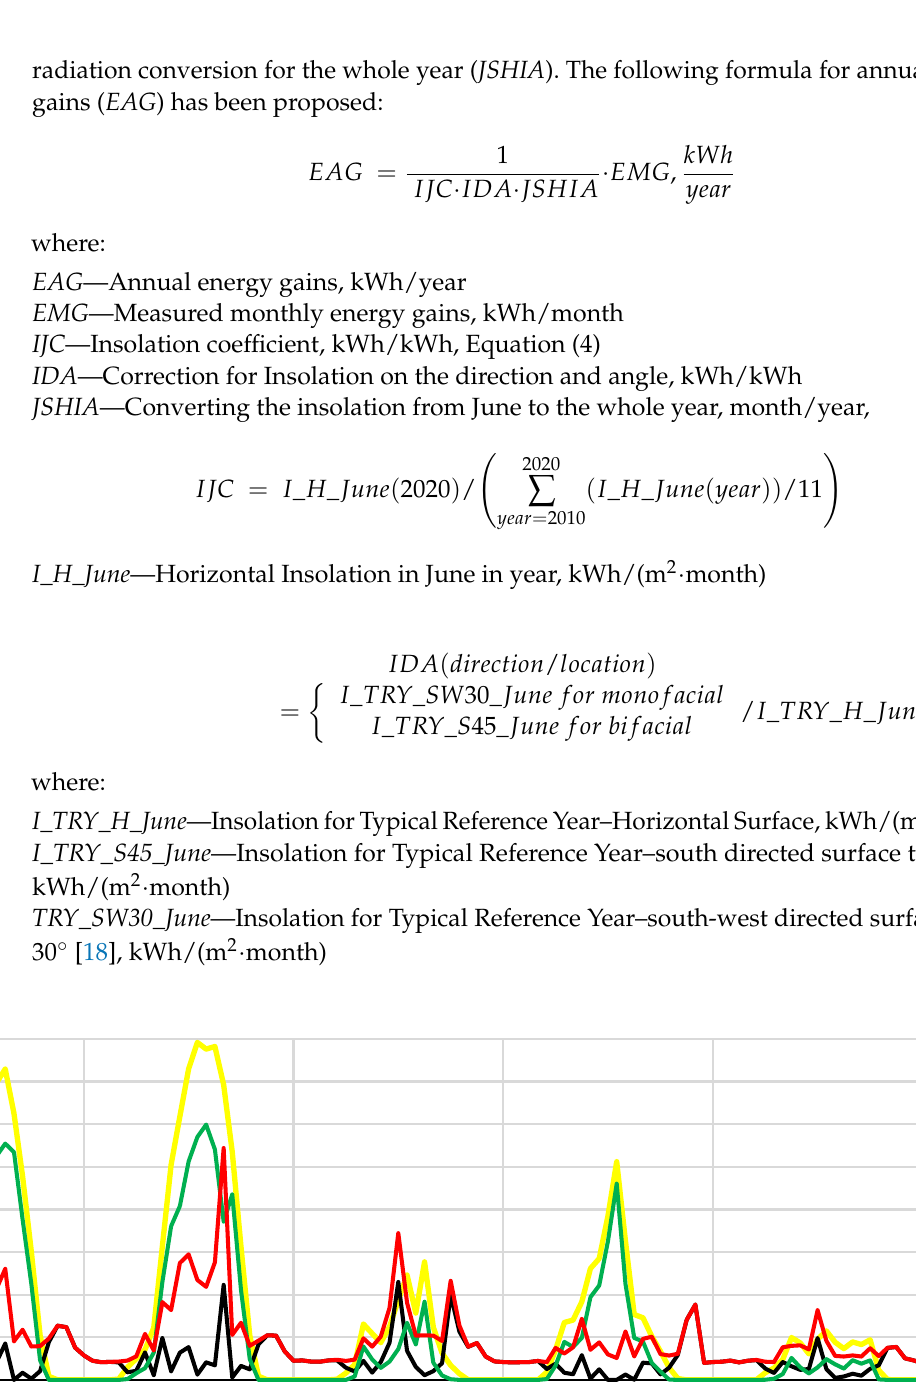
Figure 9. Self-consumption coefficient (SC) and self-sufficiency coefficient (SS) for several days of June 2020. Based on the insolation data from 2010–2020 [33], the representativeness of insolation data for the analysed June 2020 (JSHI) was determined: 𝐽𝑆𝐻𝐼 = 𝐼_𝐻_𝐽𝑢𝑛𝑒/𝐼_𝐻_𝑌𝑒𝑎𝑟 (6) where: